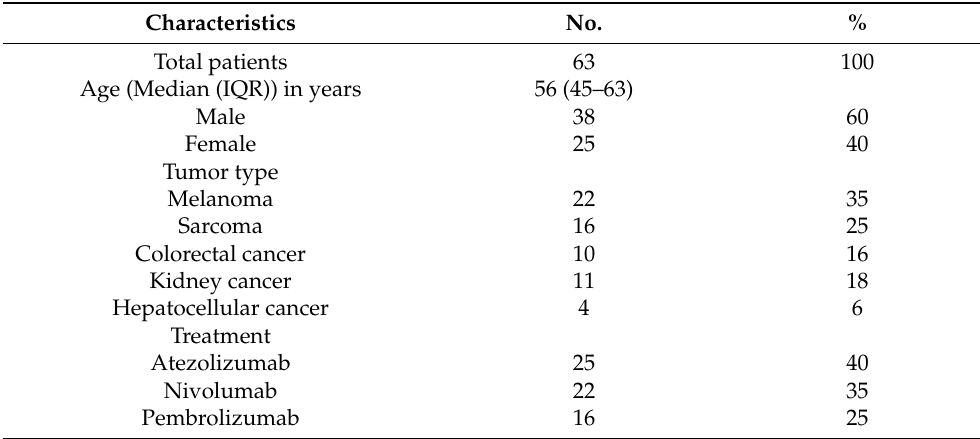
Table 1. Demographics and baseline patient